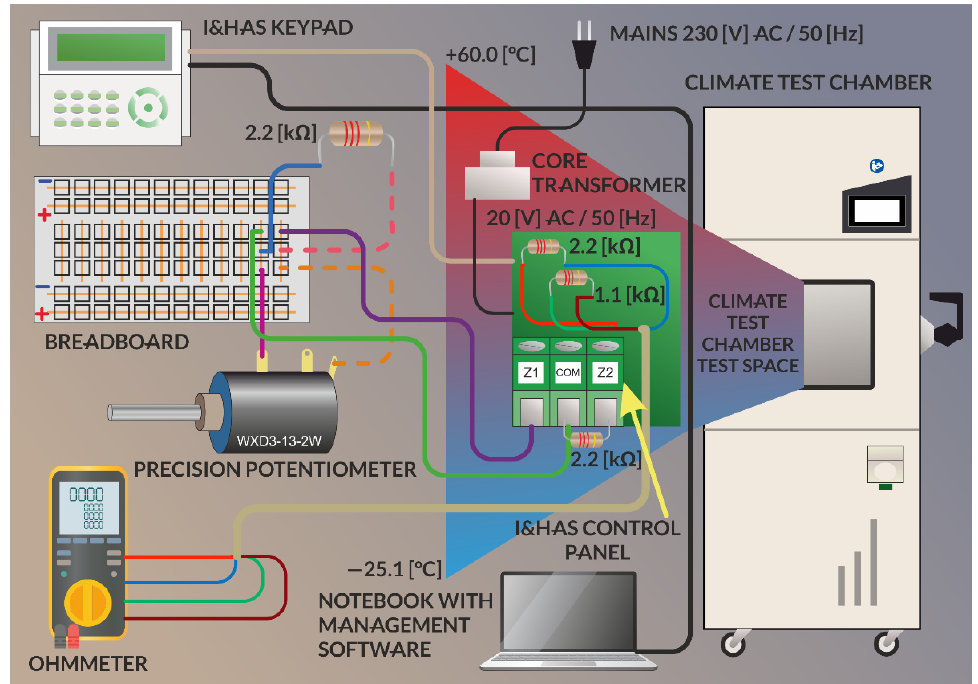
Figure 4. Block diagram of a test bench for studying temperature characteristics of layered EOL resistors and the impact of temperature on the resistance thresholds that determine the security states of IDS detection circuits.